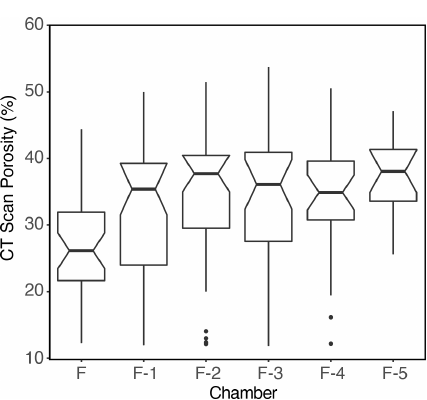
Figure 8. Boxplots of G. hexagonus test porosity, determined by inside-out analyses of CT scan images, showing an increase in porosity in the most recently formed (F) chamber.